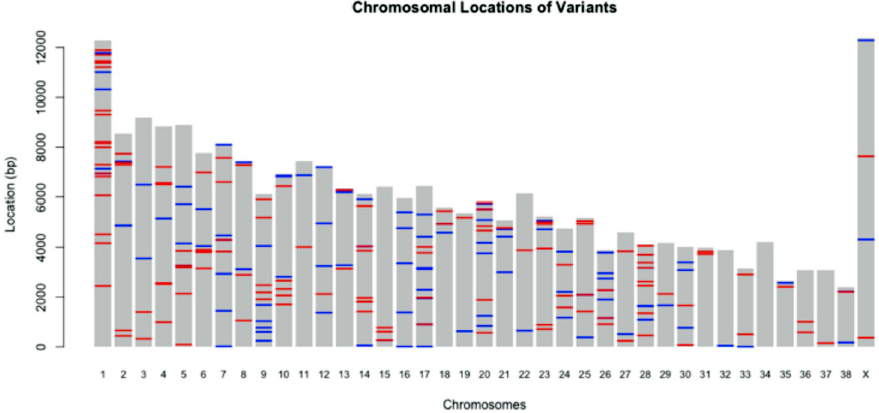
Fig 2. Location map of high/moderate impact genes on canine chromosomes. Variants in the ‘good’ outcome group are blue and variants in the ‘poor’ outcome group are red.